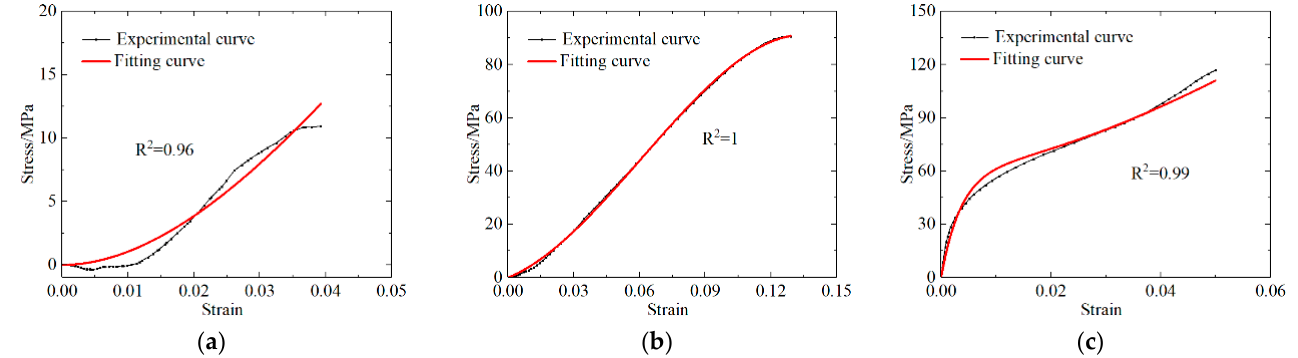
Figure 12. Comparison of PLA experimental curve and fitting curve. ( a ) Low strain rate stress difference; ( b ) low strain rate; ( c ) high strain rate.